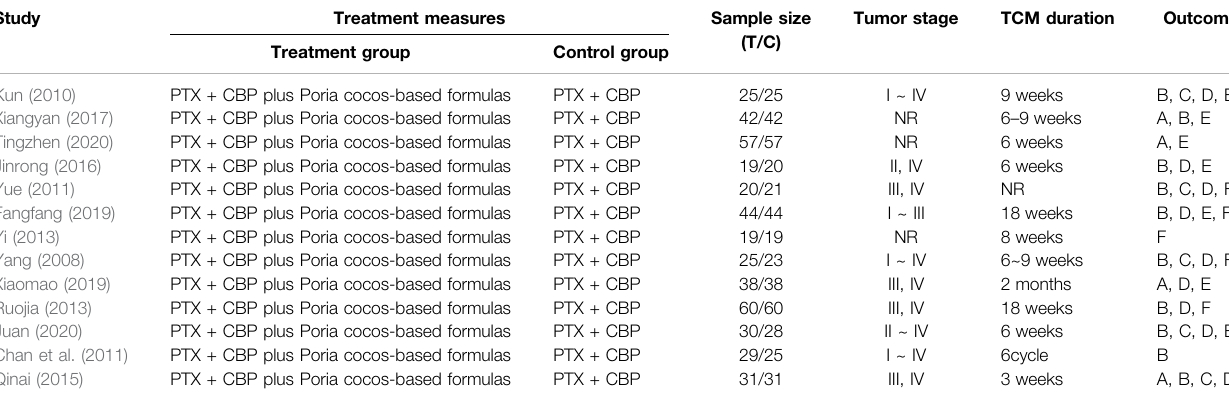
TABLE 1 | Characteristics of the included